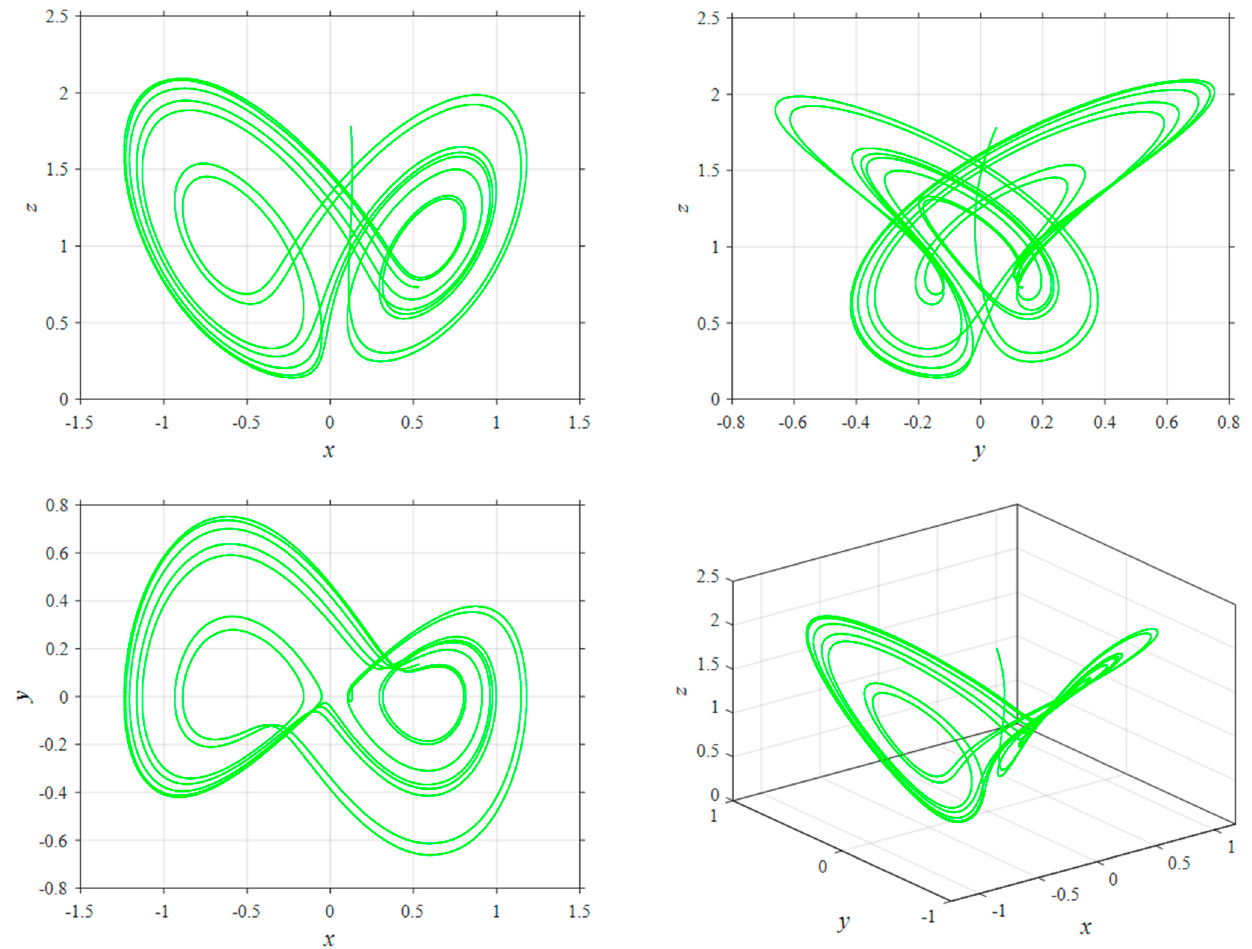
Figure 6. Fractional Shimizu-Morioka system chaotic attractor using SINC-DQM with time ( T = 100 ) and fraction λ = 0.98, γ = 0.9, a 1 = 1, a 2 = 0.375, a 3 = 0.8, and x ( 0 ) = 0.1, y ( 0 ) = 0.1, z ( 0 ) = 0.1